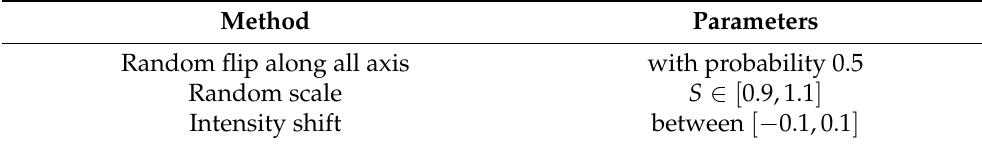
Table 1. Data augmentation